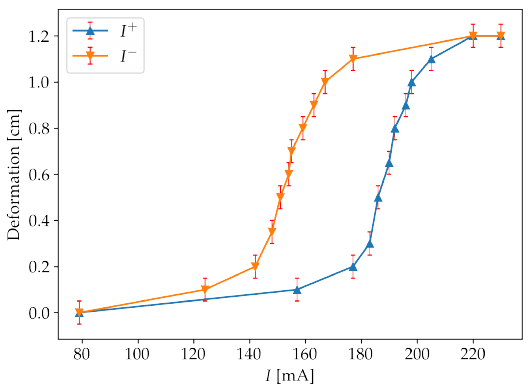
Figure 4. Plot showing deformation versus current for a Flexinol wire. I + denotes that the current is monotonically increasing, while I − denotes a monotonical